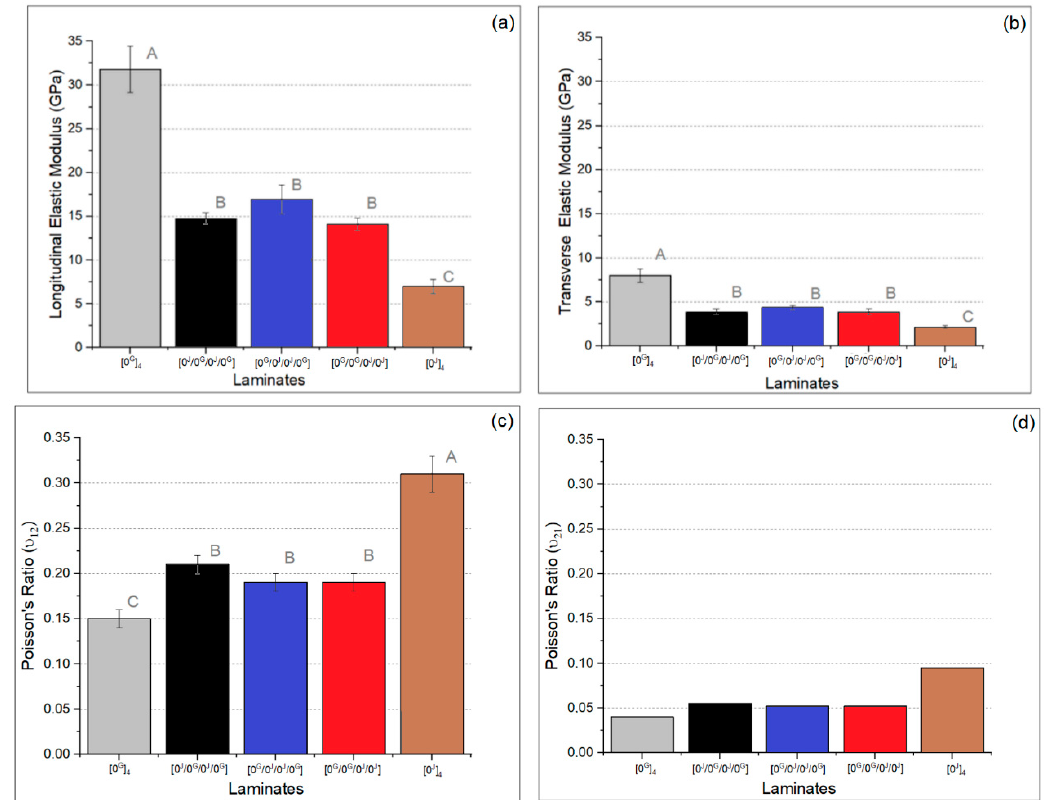
Figure 6. Longitudinal ( a ) and transverse ( b ) tensile modulus, major Poisson’s ratio ( ν 12 ) ( c ), and calculated minor Poisson’s ratio ( ν 21 ) ( d ) of the laminates (letters represent the results of the Tukey’s test). Figure 7a,b shows the longitudinal and transverse tensile strength for the laminates.